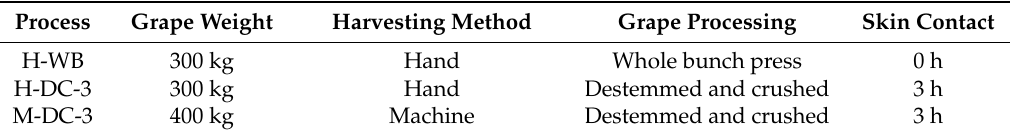
Table 1. Description of three different grape processing treatments. Process Grape Weight Harvesting Method Grape Processing